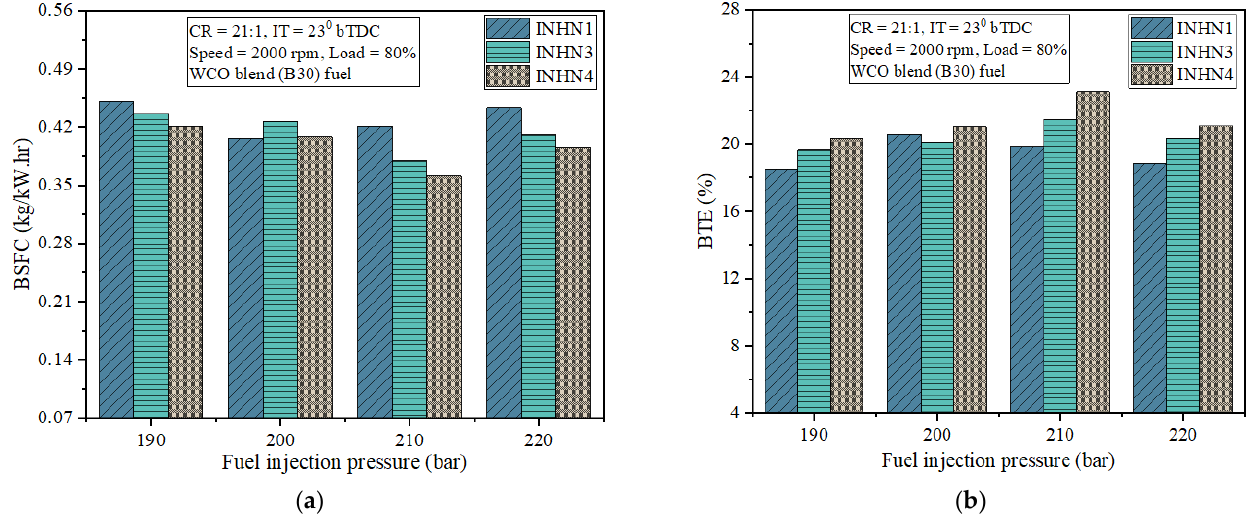
Figure 16. Influences of INHNs and fuel IPs on engine performance: ( a ) BSFC and ( b ) BTE.